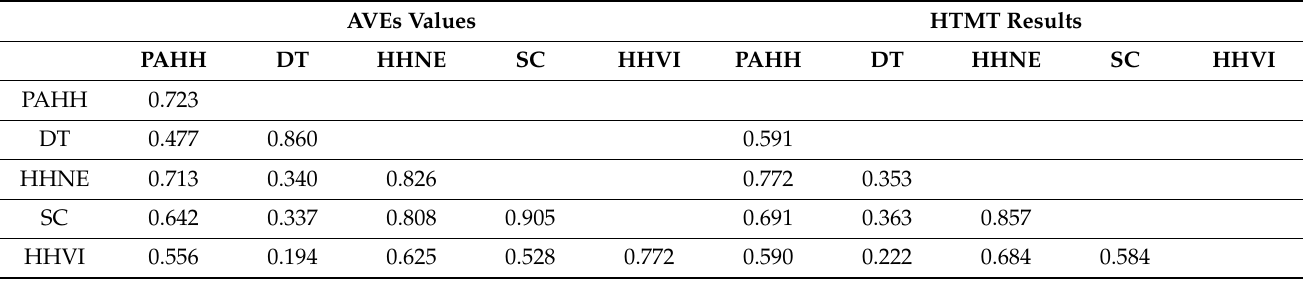
Table 3. Inter-construct correlations, the square root of AVE, and HTMT results.